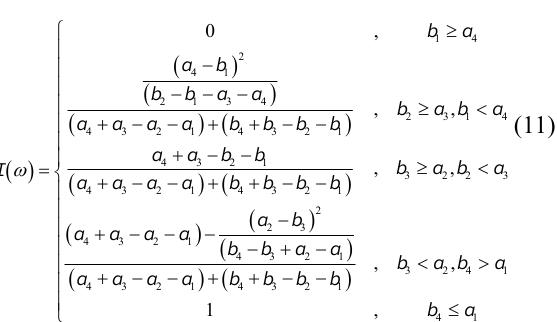
Fig. 2. Comparison of fuzzy